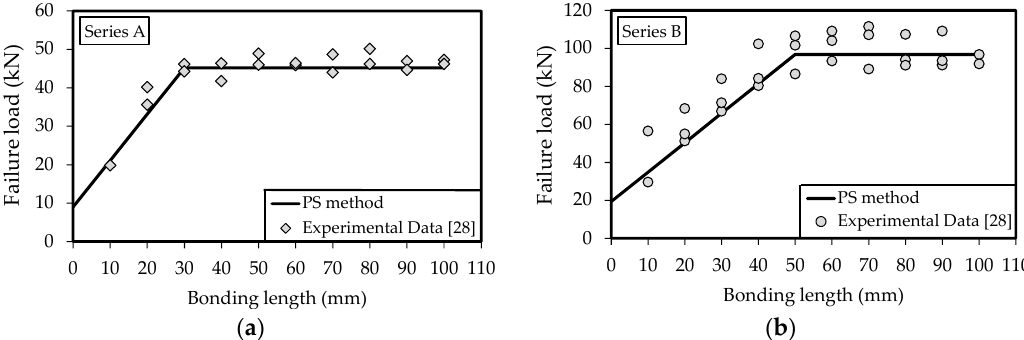
Figure 11. Comparison between the experimental failure loads of DSJs and the theoretical predictions obtained by means of PS method; ( a ) series A; ( b ) series B.